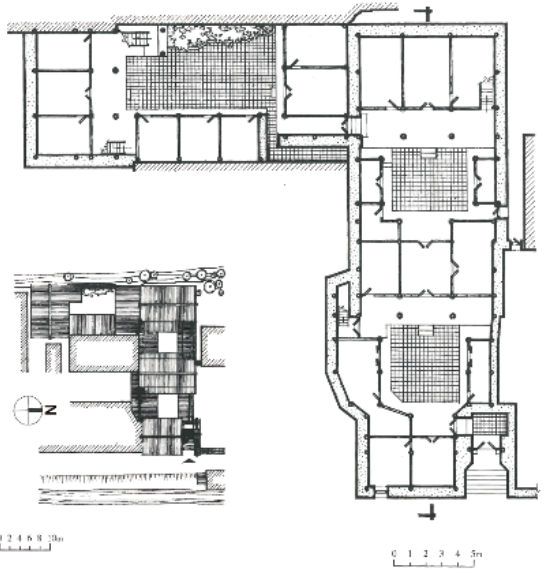
Figure 17. Floor plan of ground level of Case C (left ); site plan of Case C. Th e Hes, 87, Xinhua street built circa 1900 (right) (source: Zhu, 2020; personal communication, 18 January)